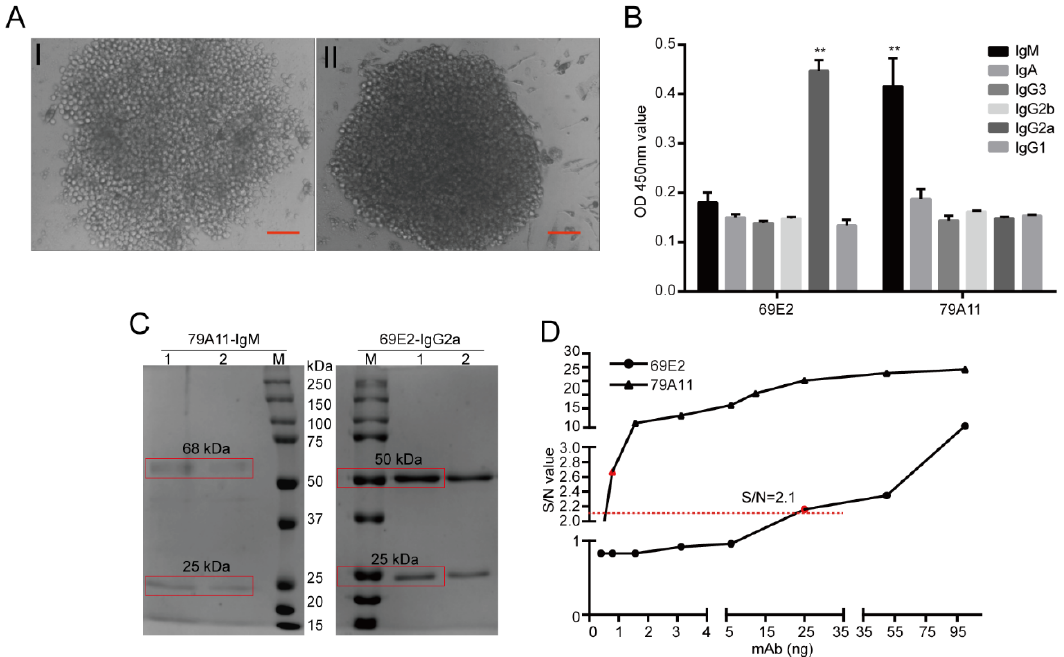
Figure 2. Preparation of the mAbs against the HPV16 E7-HIS fusion oncoprotein. ( A ) I and II were hybridoma cells at the 8th day after SP2 / 0-Ag14 were fused with immuned BABL / c lymph node cells and spleen cells, respectively. Scale bar = 500 µ M ( B ) Subtypes were identified as IgM and IgG2a subtypes by using the mouse monoclonal antibody isotyping reagents (SIGMA). ** represents p < 0,01, compared with other kinds of immunoglobulins (Igs) by using the One-way Analysis of Variance (ANOVA) with post-hoc Tukey Honestly Significant Di ff erence (HSD) for multiple comparison. ( C ) 12% SDS-PAGE of the IgM subtype mAb 79A11 purified by Protein A. 25 and 68 kDa were the light and heavy chains of IgM mAbs (left); 12% SDS-PAGE of the IgG2a subtype mAb 69E2 purified by Protein G. 25 kDa and 50 kDa were the light and heavy chains of the IgG2a subtype mAbs (right). The red box represents the bands of HPV16 E7. ( D ) Indirect ELISA assay for the purified mAb titer. mAb, Monoclonal antibody. The red dotted line presents S / N ratio = 2.1.